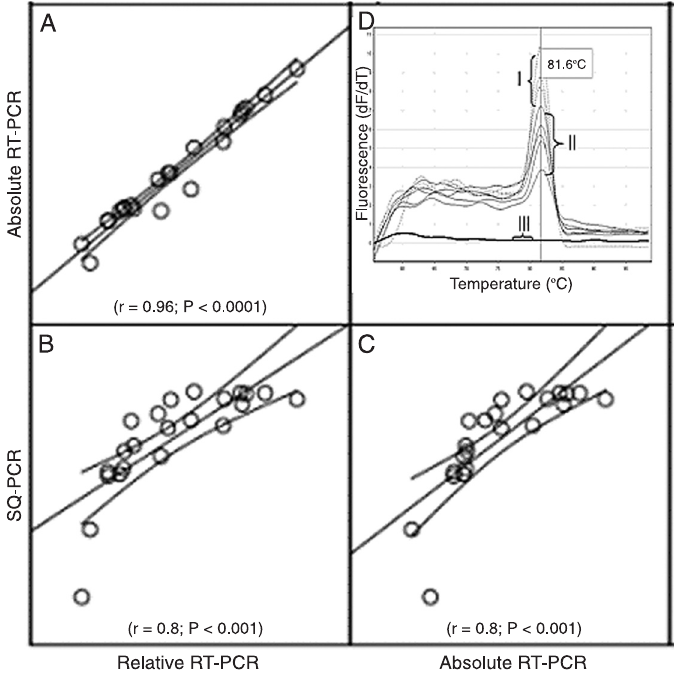
Figure 2. Detection of MYCN and melting curve analysis after amplification of the MYCN gene. A , Correlation of absolute and relative real-time quantita- tive PCR (RT-PCR). B , Correlation of relative RT-PCR and semi-quantitative differential PCR (SQ-PCR). C , Correlation of absolute RT-PCR and SQ-PCR. The results are plotted on a logarithmic scale and compared by linear regres- sion analysis. D , Plasmid containing a 178-bp insert of MYCN, neuroblasto- ma patients with unamplified MYCN gene, and no template control indicated by the Roman numerals I, II, and III,